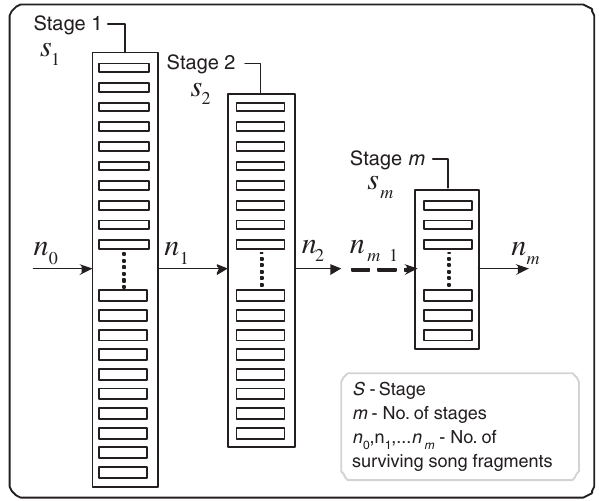
Figure 4. Multistage Representation of PF.